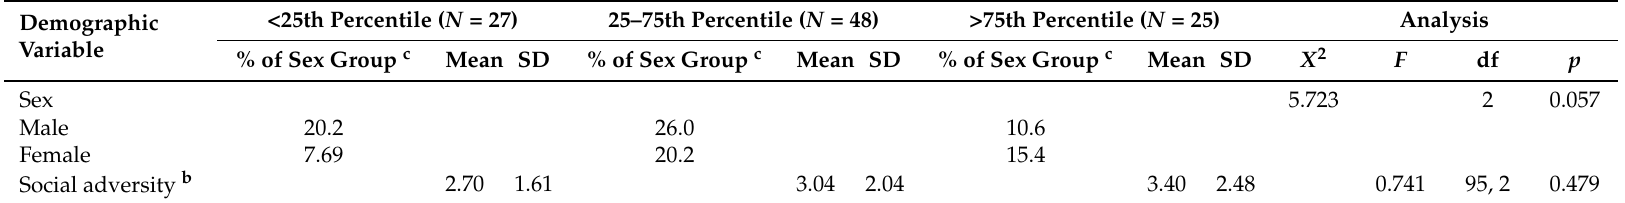
Table 2. Demographic measures among children stratified by hemoglobin levels a at age 4.